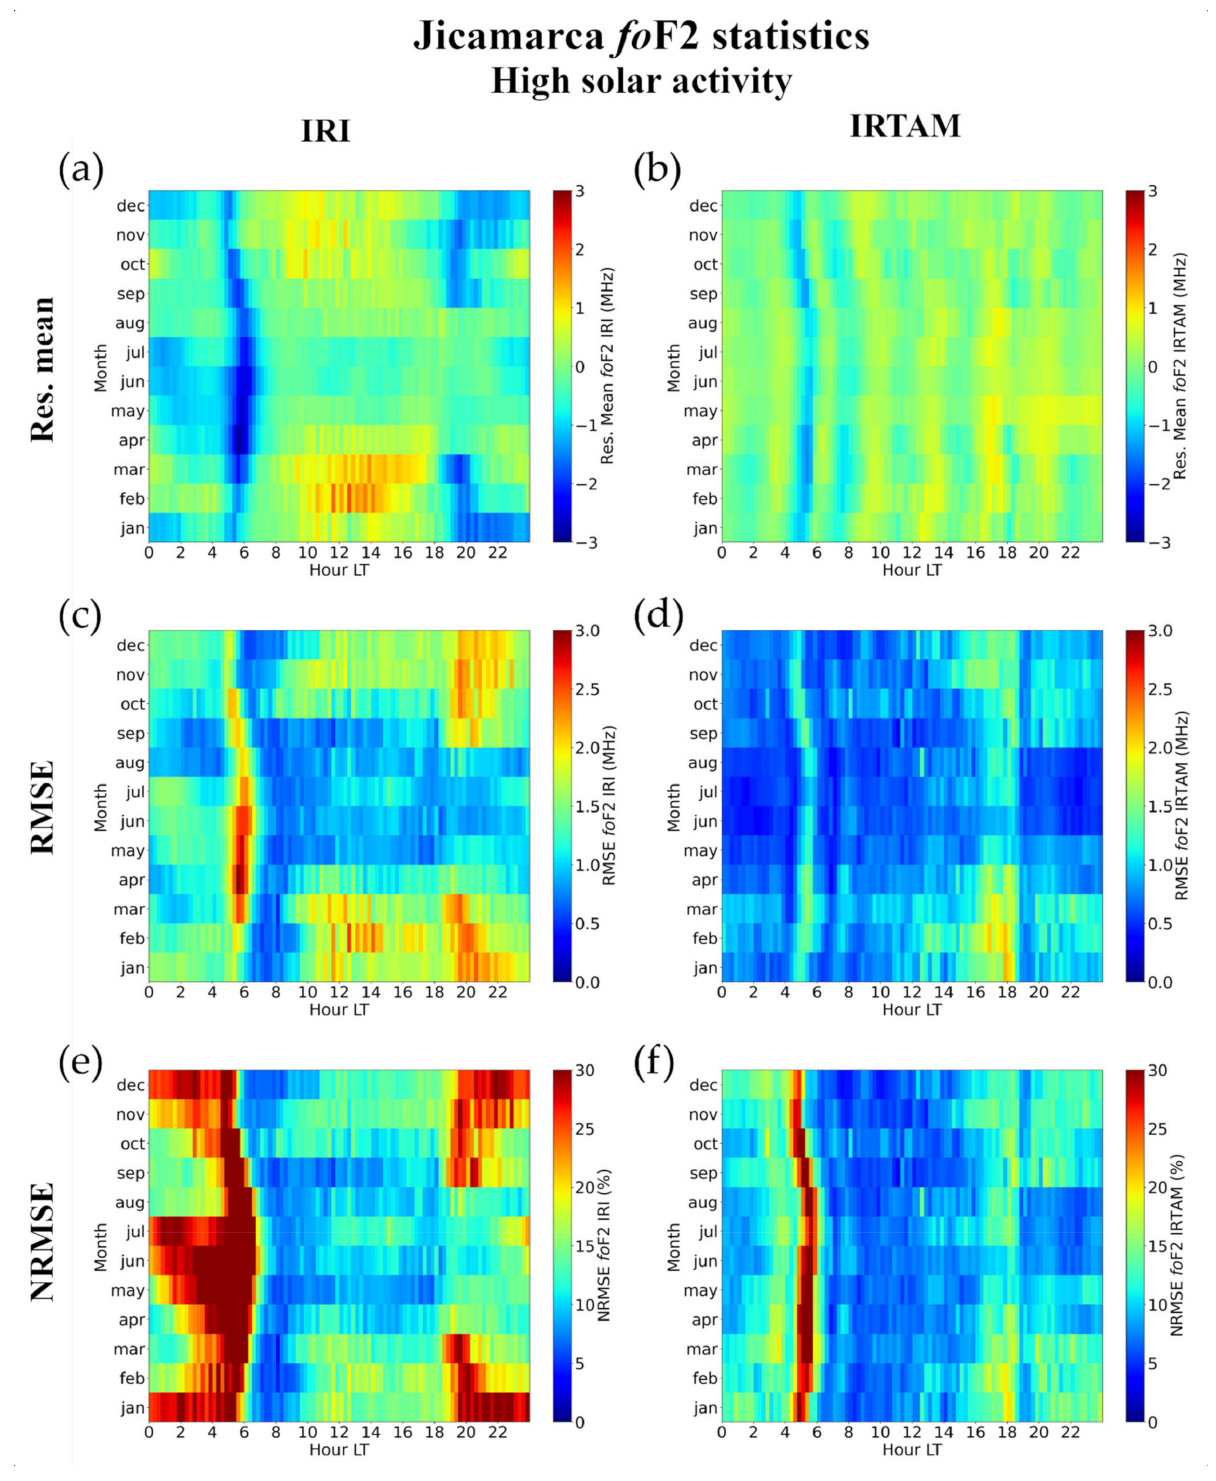
Figure 6. Same as Figure 4 but for HSA